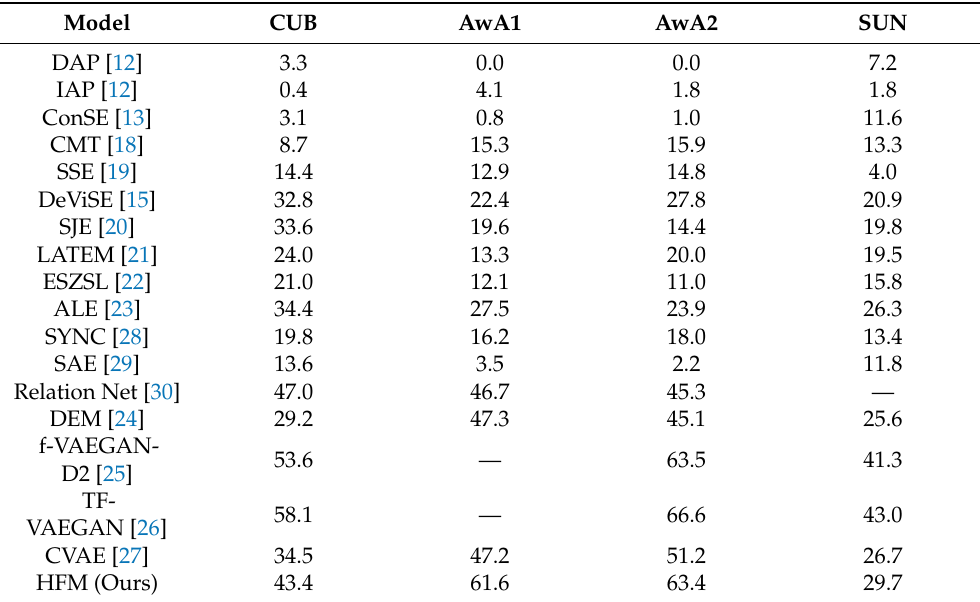
Table 2. Results of Generalized Zero-Shot Learning (GZSL) settings.We used the harmonic mean of accuracy on both seen and unseen classes as a measure.